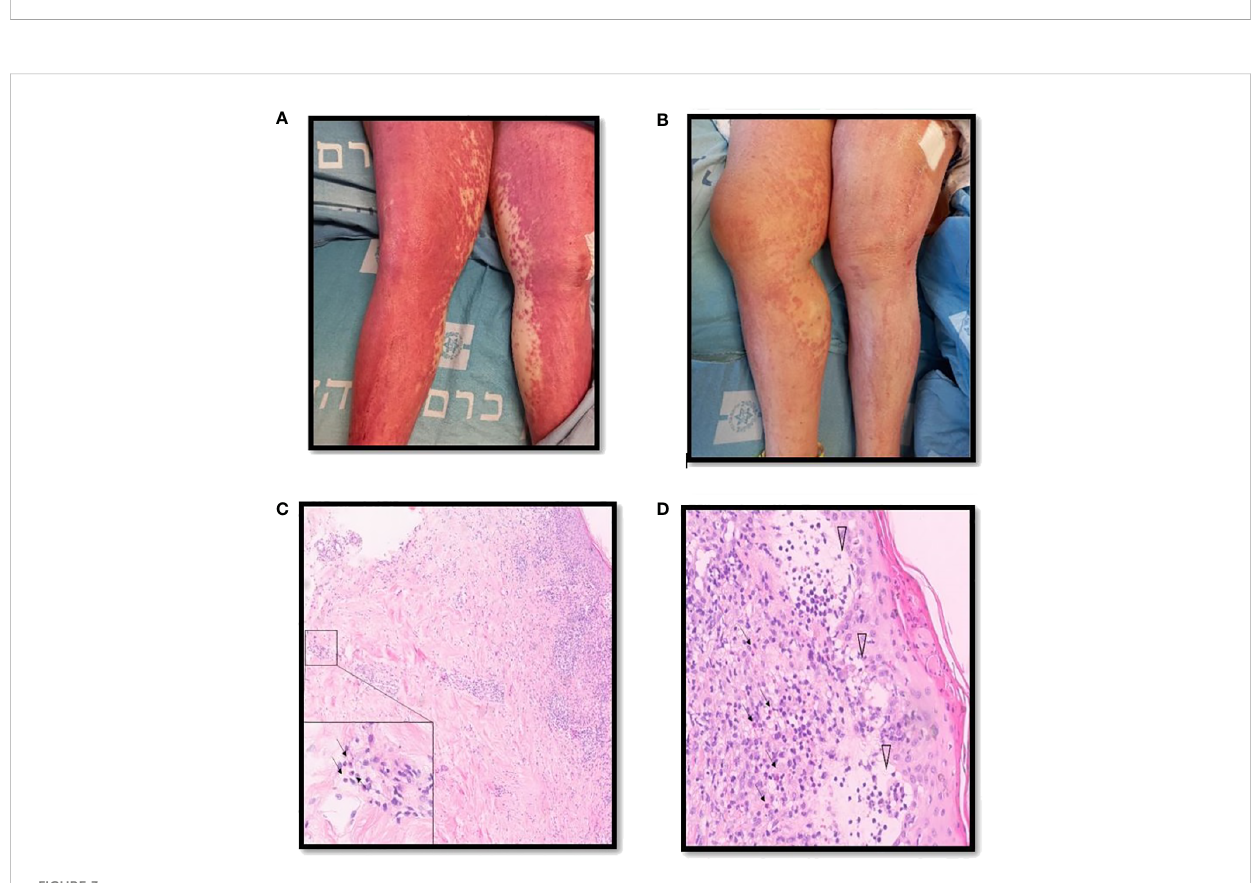
FIGURE 3 Clinical description and skin histopathology of the patients. (A) Clinical presentation of DRESS in patient 2 consisting of diffuse erythematous rash involving the lower limbs. (B) One week following benralizumab therapy, partial resolution of the skin rash. (C) Punch biopsy of skin consisting of hematoxylin and eosin stain demonstrating changes compatible with the clinical diagnosis of DRESS, most notably an in fl ammatory in fi ltrate composed of lymphocytes and numerous eosinophils stretching from the epidermis to the deep dermis in ×10 magni fi cation. The inset demonstrates eosinophils present in the deep dermis in ×100 magni fi cation (arrows). (D) Secondary changes including parakeratosis and interstitial edema with blister formation in the papillary dermis (arrowheads) in ×40 magni fi